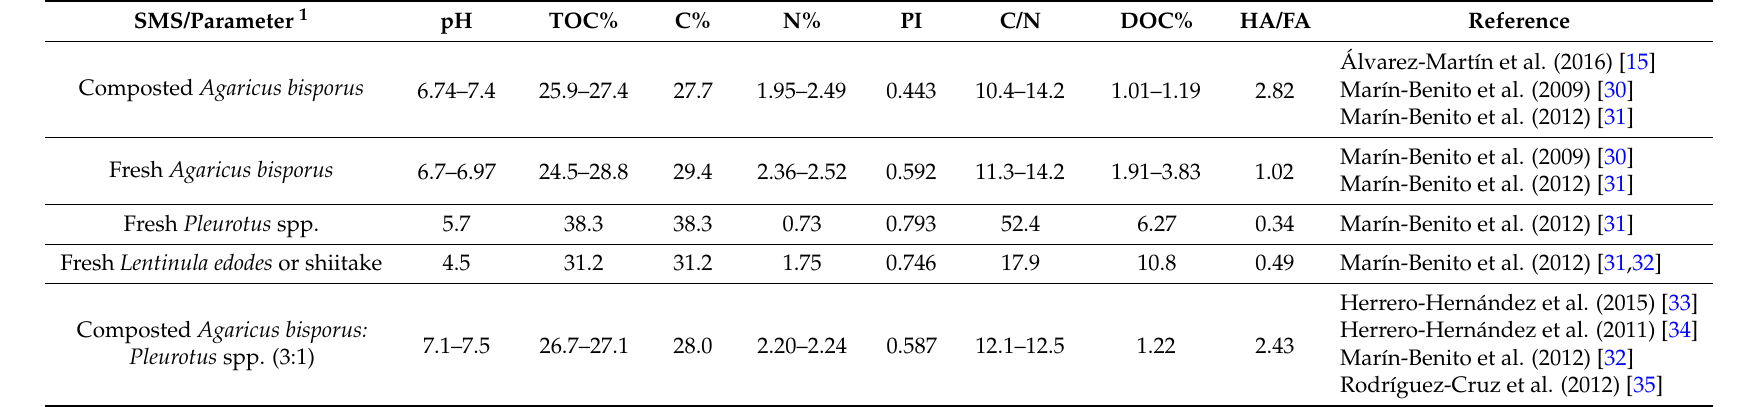
Table 1. Characteristics of main SMS used.